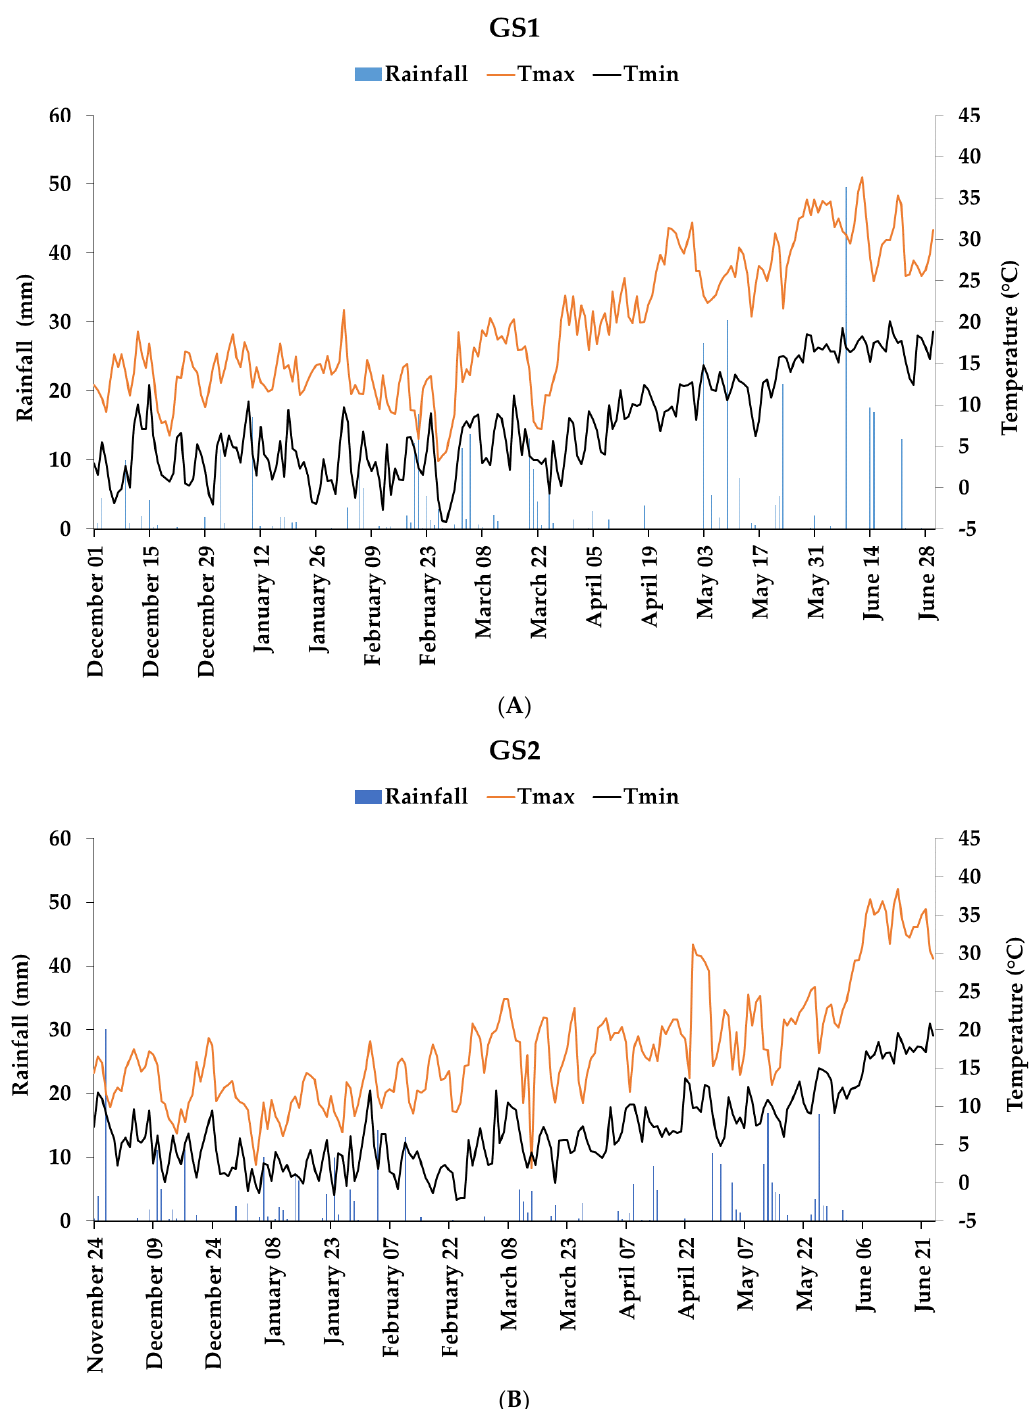
Figure 3. Daily rainfall and maximum and minimum temperatures in the two growing seasons, GS1 ( A ) and GS2 ( B